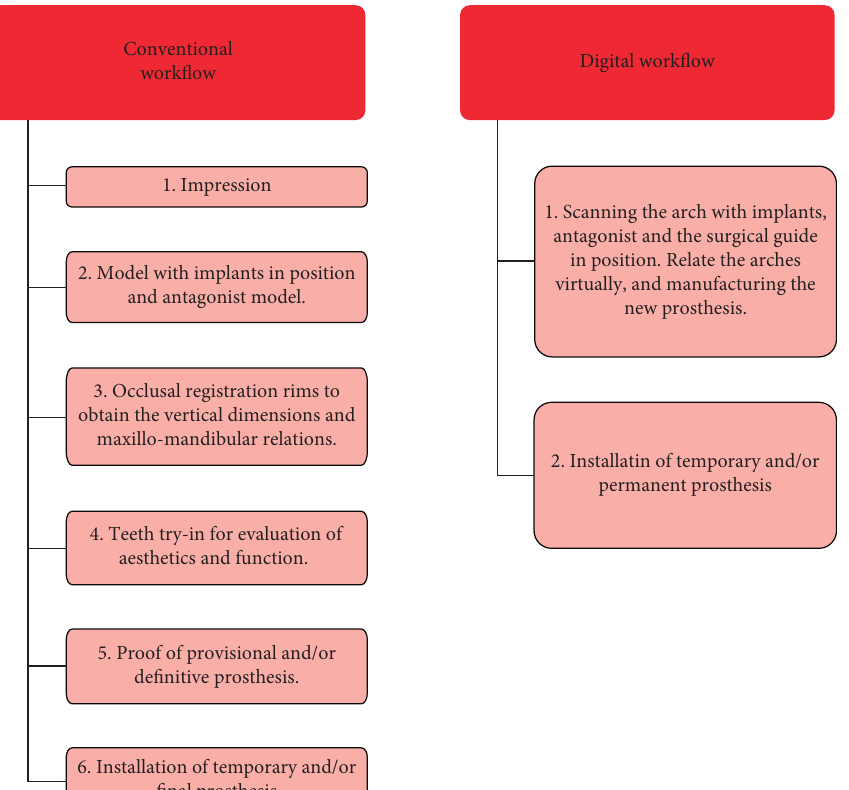
Figure 1: Conventional versus digital workflow in implantology